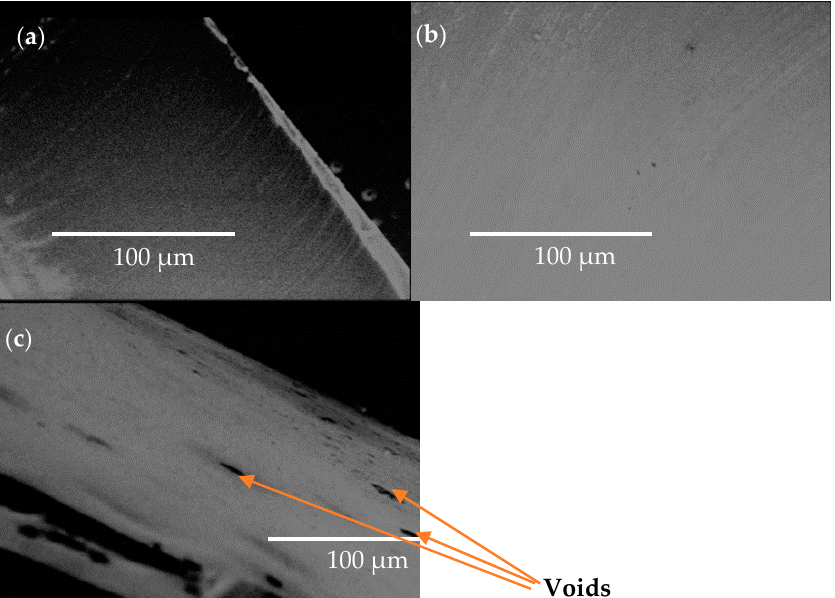
Figure 3. SEM images of Pellethane TPU ( a ) without CO 2 (control), ( b ) with CO 2 at 4.14 MPa, and ( c ) with CO 2 at 6.89 MPa (images captured at x400, 18 kV, and 100 μ m).